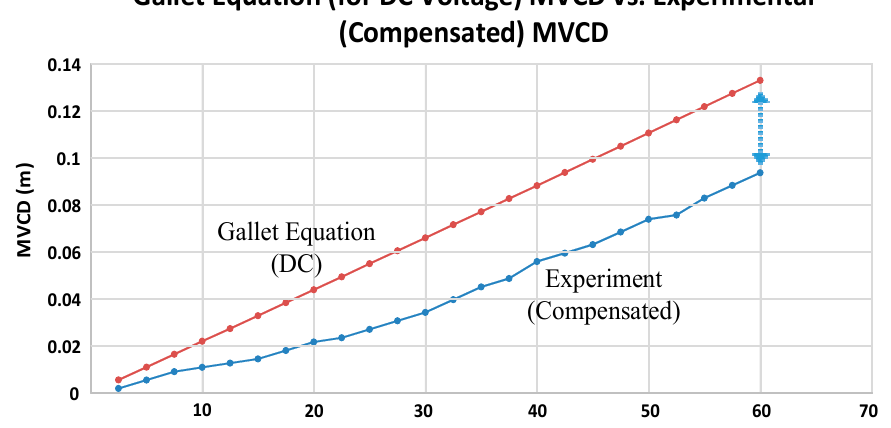
Figure 5. Experimental MVCD vs. Gallet MVCD. Energies 2018 , 11 , x FOR PEER REVIEW 8 of 10